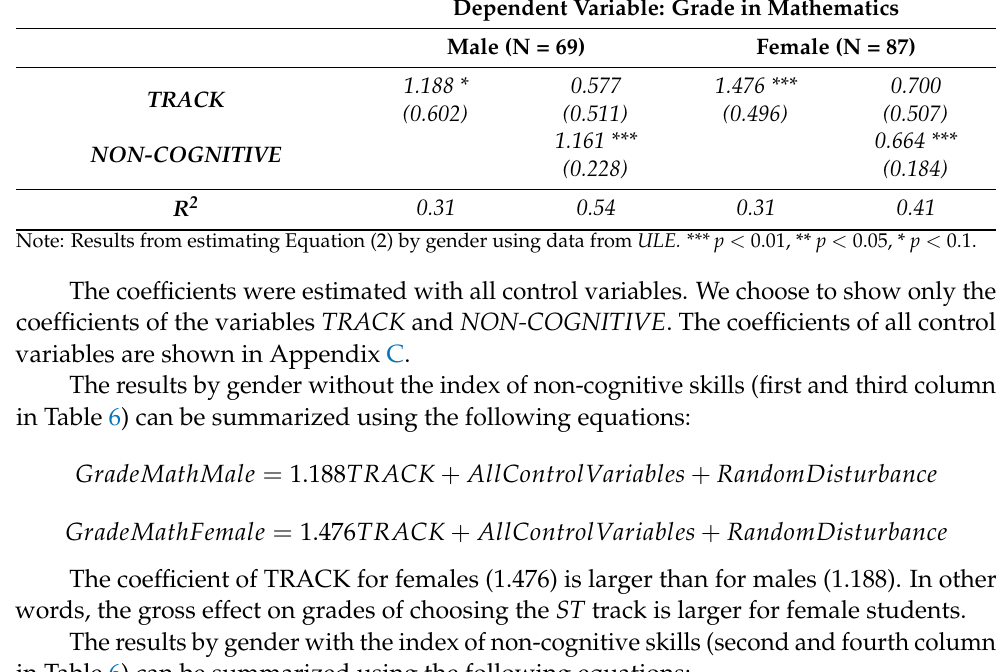
Table 6. Coefficients of linear models explaining grades by gender. TRACK NON-COGNITIVE R 2 0.31 0.54 0.31 0.41